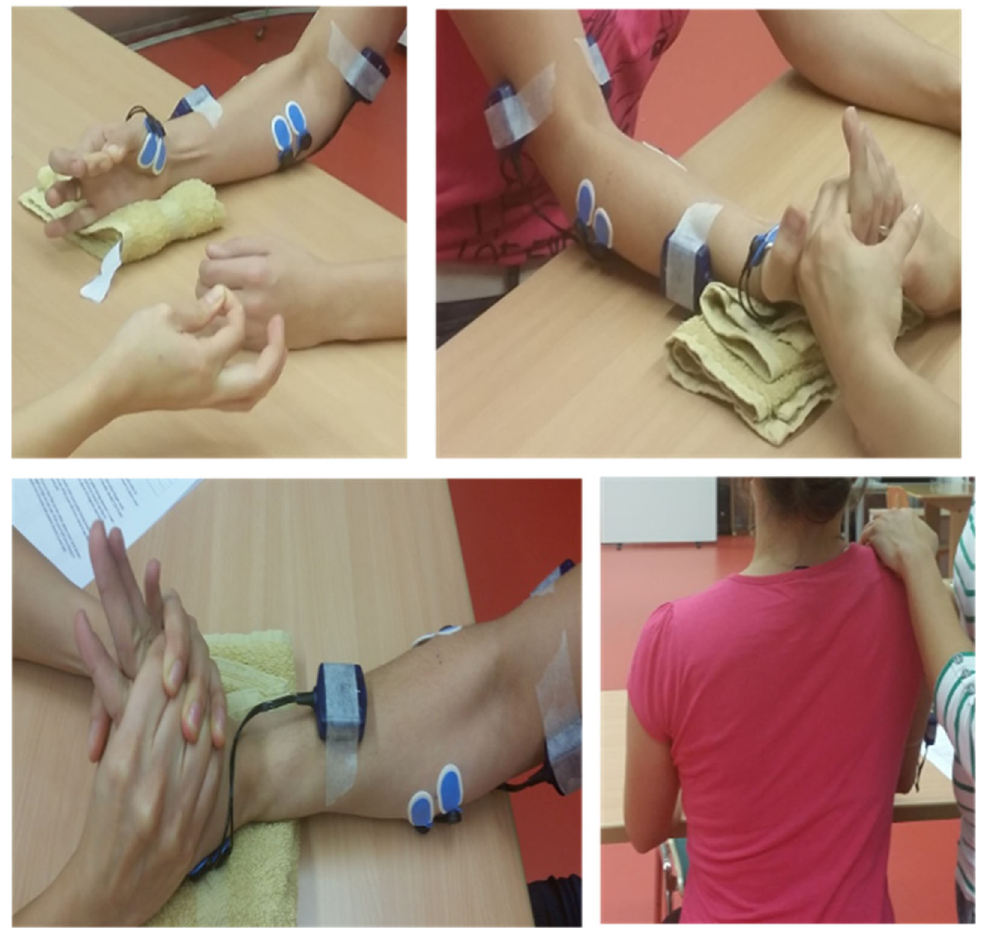
Figure 3. Tasks for maximal/submaximal voluntary contraction to normalize sEMG data for each of the four muscles.